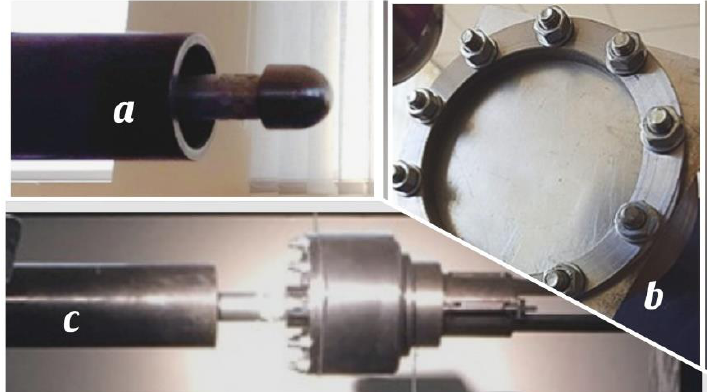
Figure 1. Hopkinson bar set-up for experimental testing of the polyurea-polyurethane-MWCNTs nanocomposite-coated aluminum plates in dynamic regime: ( a ) Spherical head projectile; ( b ) sam- ple before the experiment (coated on the backside with polyurea (PU) or polyurea-polyurethane- MWCNTs nanocomposite (PU-NC)); ( c ) image captured during the experiment, at the moment of the impact of the projectile with the sample.